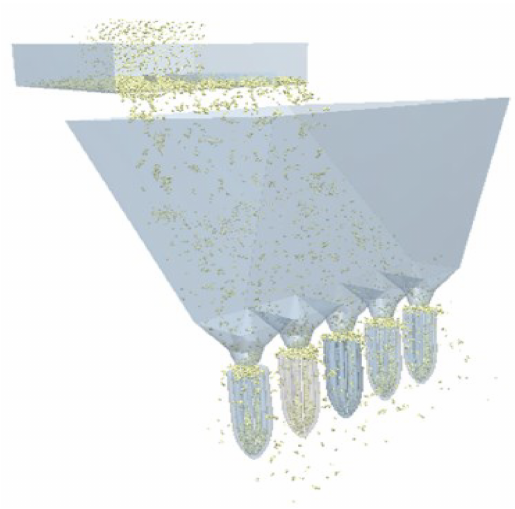
Figure 4. Simulation process of vibrating rice filling.